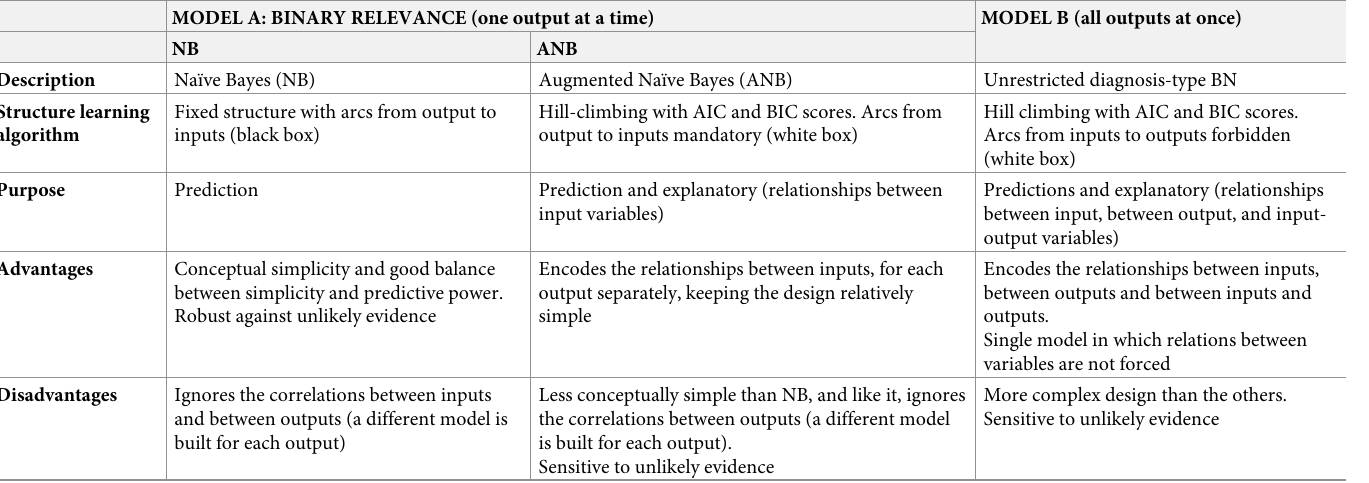
Table 3. Description and main characteristics of the three types of BNs.